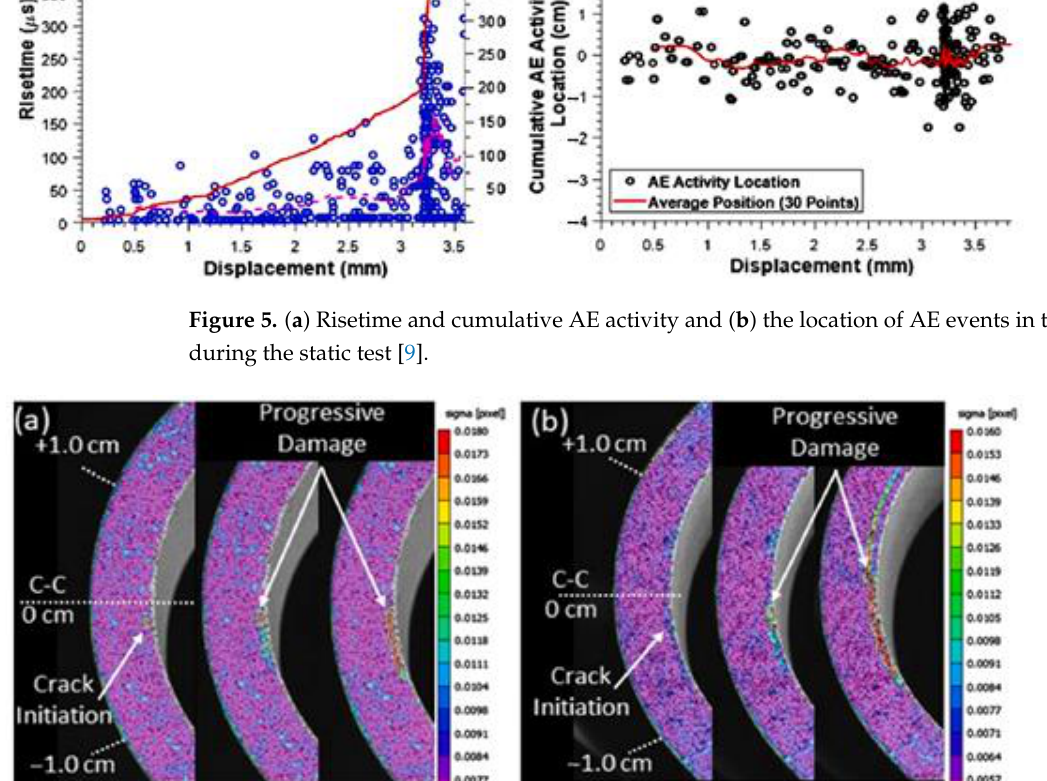
Figure 5. ( a ) Risetime and cumulative AE activity and ( b ) the location of AE events in the speci- men during the static test [9].